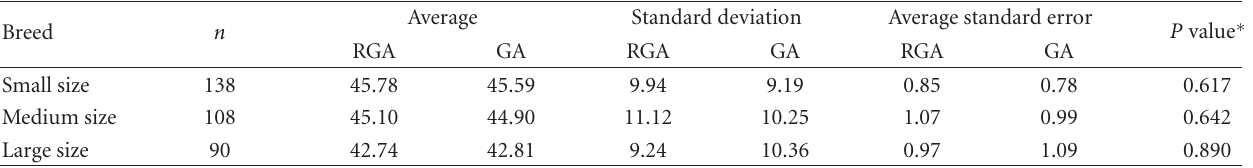
Figure 3: Scatter plot of the correlation between the gestational age defined by the potential adjustment and the reported age for the small ( y = 0 . 0087 x 1 . 0637 —(a)), medium ( y = 0 . 0109 x 1 . 0412 —(b)), and large ( y = 0 . 0153 x − 0 . 0737—(c)) size breed. Table 2: Di ff erence between gestational ages calculated by curves adjustments and reported age averages for small, medium, and large size breeds and statistical